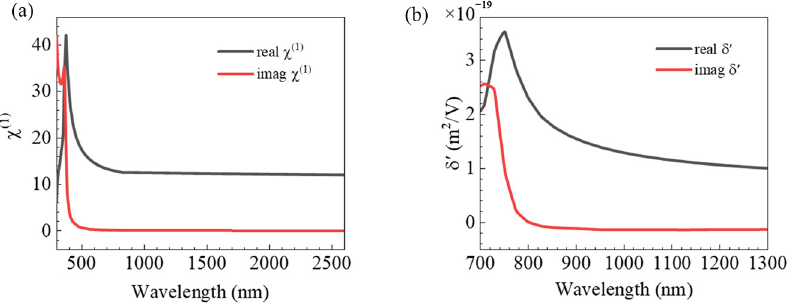
Figure 5. ( a ) Frequency dispersion of linear susceptibility of silicon. ( b ) Frequency dispersion of second-order susceptibility of silicon.